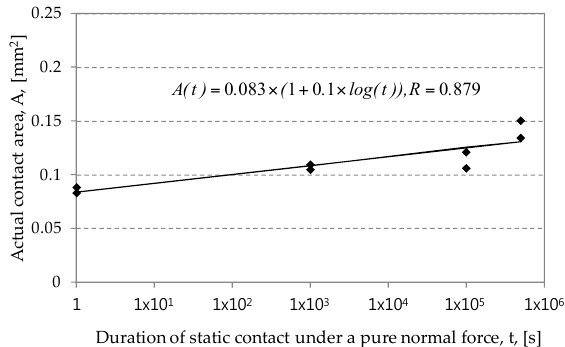
Figure 4. Actual contact area as a function of duration of static contact at a normal force of 49 N. A smooth line denotes a fitted curve.